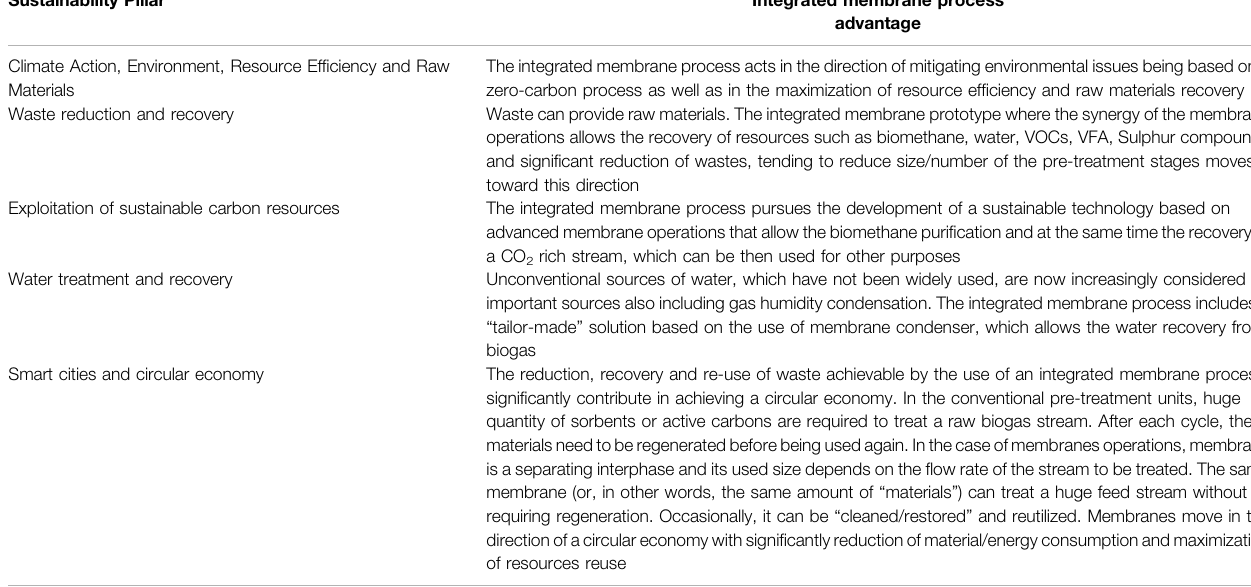
TABLE 1 | How the integrated membrane process can fi t the main sustainability pillars. Sustainability Pillar Integrated membrane process